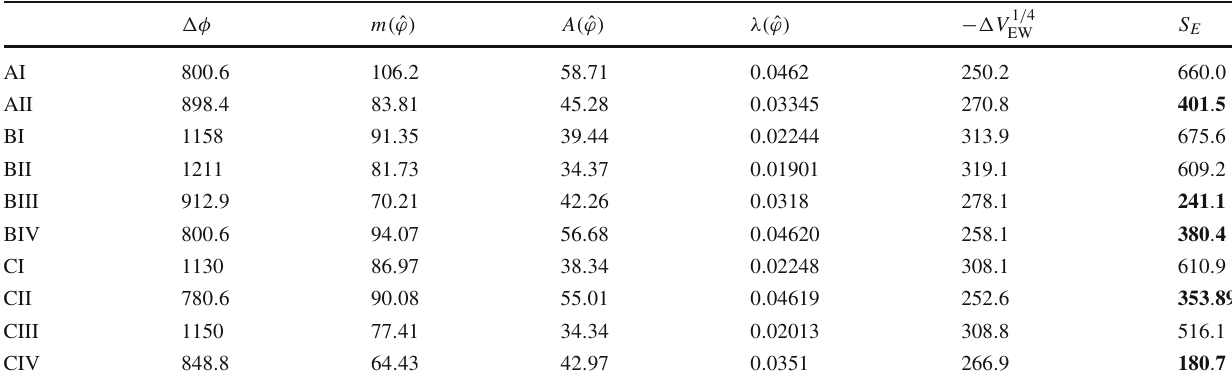
Table 3 Values for the coefficients m , A and λ as defined in Eq. (26) for the non-EW minima shown in Table 2. Also shown are the distance in field space (cid:11)φ and the potential difference − (cid:11) V 1 EW minimum and the unphysical minima. The last column shows the